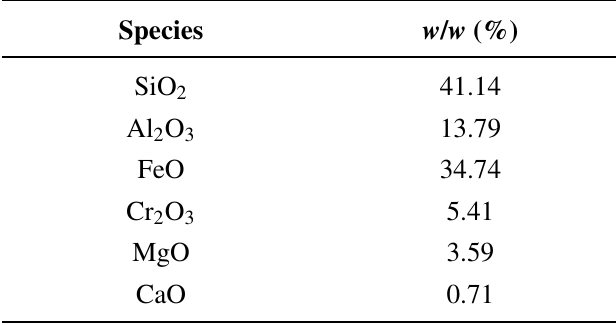
Table 1. Chemical analysis of the FeNi-slag